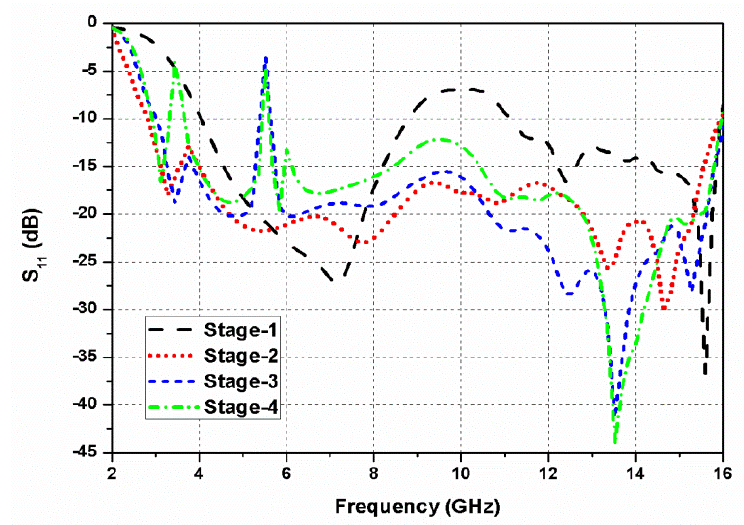
ffi cients comparison of the evolution Figure 3. Simulated reflection coefficients comparison of the evolution steps. Figure 3. Simulated reflection coe